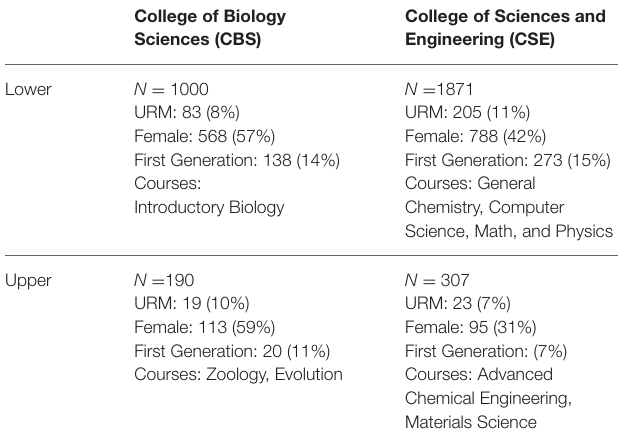
TABLE 3 | Descriptive statistics of the data used for structural equation modeling.